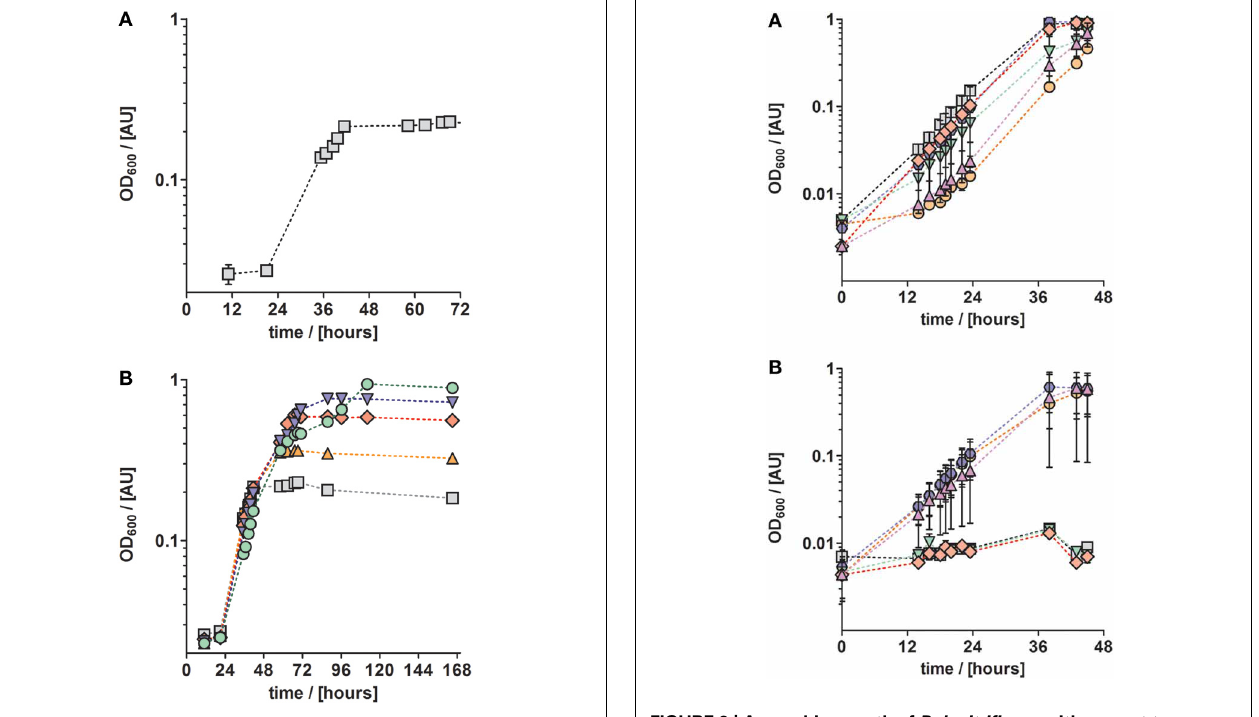
FIGURE 2 | Growth curves of anaerobically grown P. denitrificans Pd1222 on freshwater medium supplemented with a chelated trace element solution after Widdel and Bak (1992, Table 1). (A) Growth with 5mM nitrate and 10mM acetate. (B) Growth with different concentrations of electron donor (acetate) and acceptor (nitrate) to investigate whether a component of the medium is limiting. Concentrations were 5mM nitrate, 10mM acetate (gray squares), 10mM nitrate, 20mM acetate (orange up triangles), 20mM nitrate, 40mM acetate (red diamonds), 30mM nitrate, 60mM acetate (blue down triangles), 50mM nitrate, 100mM acetate (green circles). The graphs represent three replicates; error bars indicate standard deviation and may be smaller than the symbols.